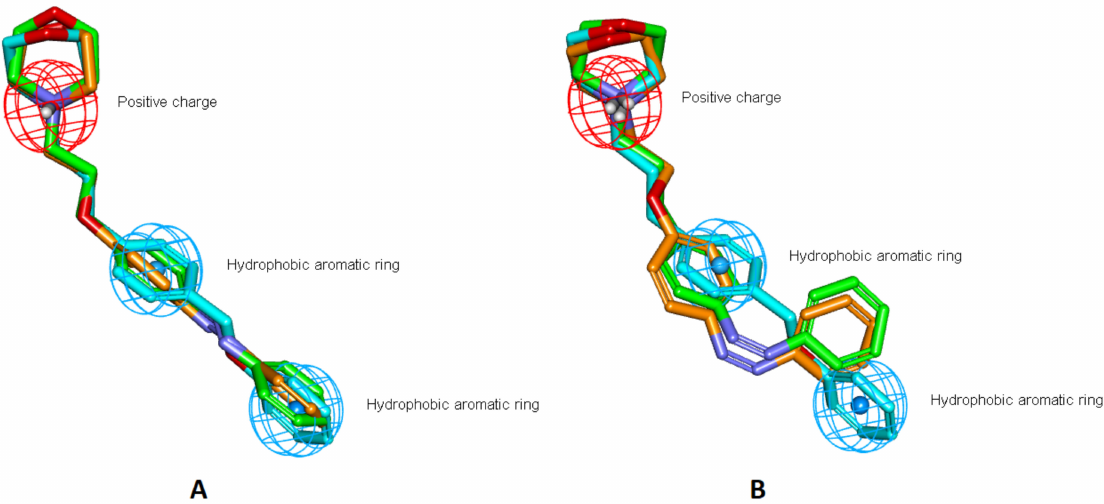
Figure 3. Comparison of predicted 3D structures of fotocaine and ethercaine in trans ( A ) and cis ( B ) forms. Fotocaine, ethercaine, and fomocaine are shown in green, orange, and cyan,